Question: In a single sentence, describe what this figure presents.
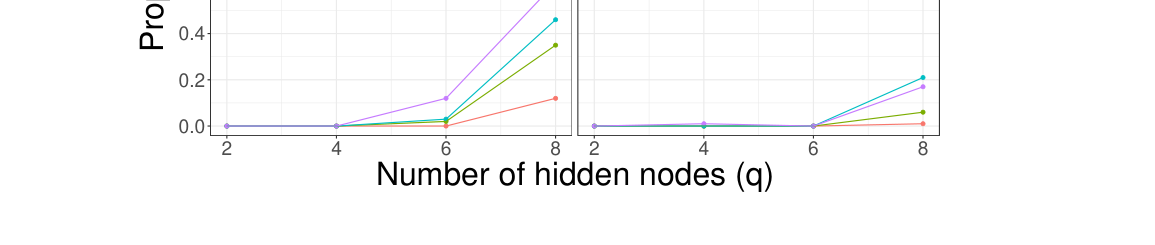
Answer: The proportion of replicates that the computation of EDF failed due to a non-invertible Hessian matrix.